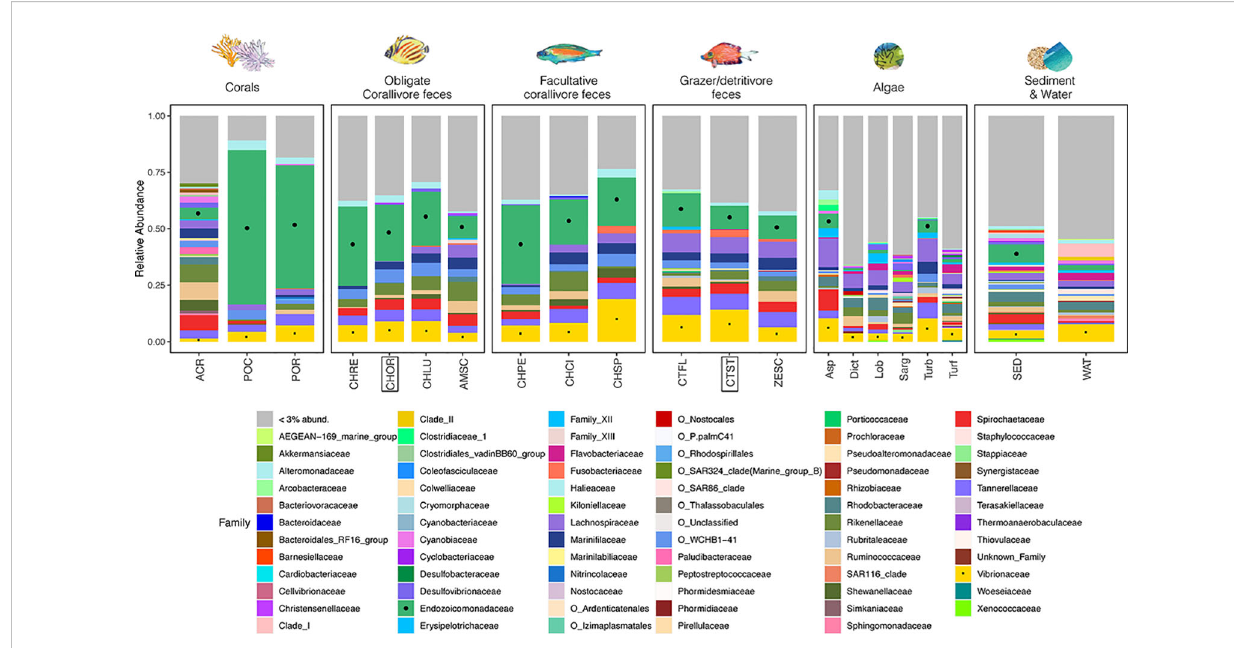
Figure 3; Table S5), as well as up to 12.9% of the ASVs associated with algal samples (47 of 363 ASVs associated with turf